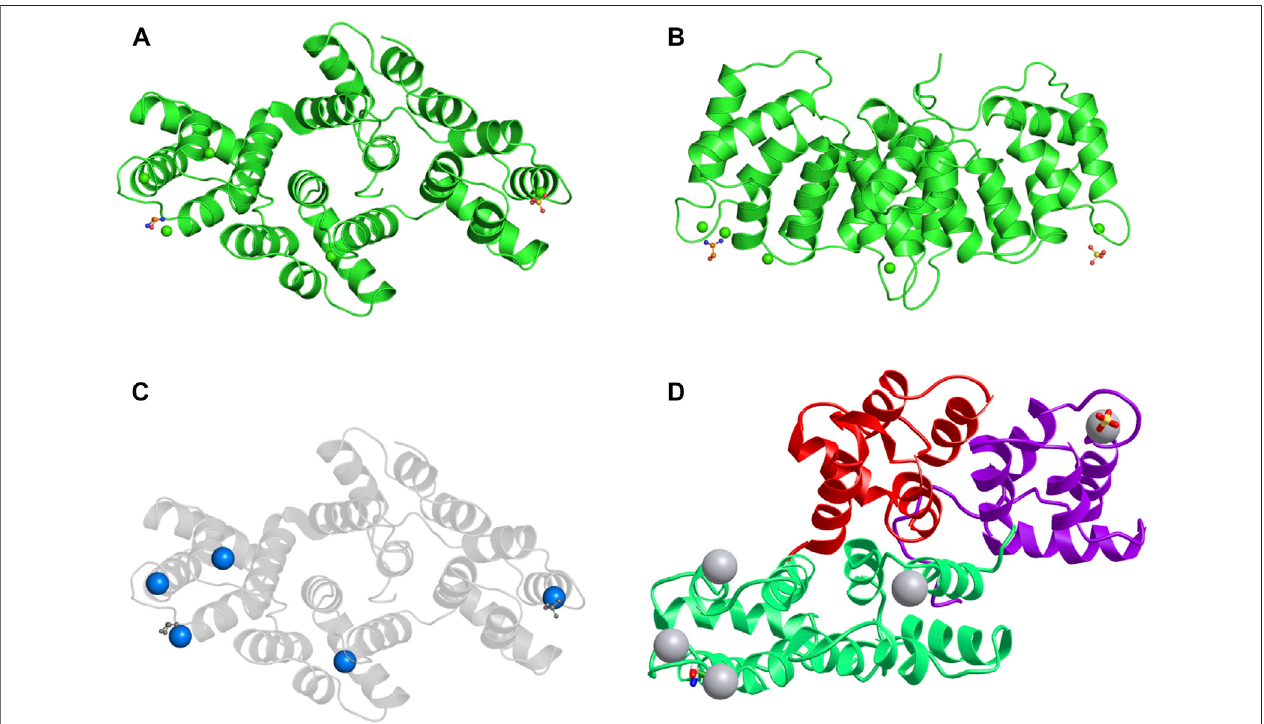
FIGURE1 | The structure ofthe ANXA3 protein. (A,B) 3D structure ofANXA3 colored by chain and viewed from the front (A) and side (B) . (C) 3D structure viewed from front with calcium-binding sites indicated by calcium ions colored as blue spheres. (D) 3D structure colored by domain. 5 a -helices are clearly visible in each structural domain. The remaining two chemical structures are one sulfate ion and one ethanolamine. Data derived from Protein Data Bank and iCn3D web-based 3D structure viewer.